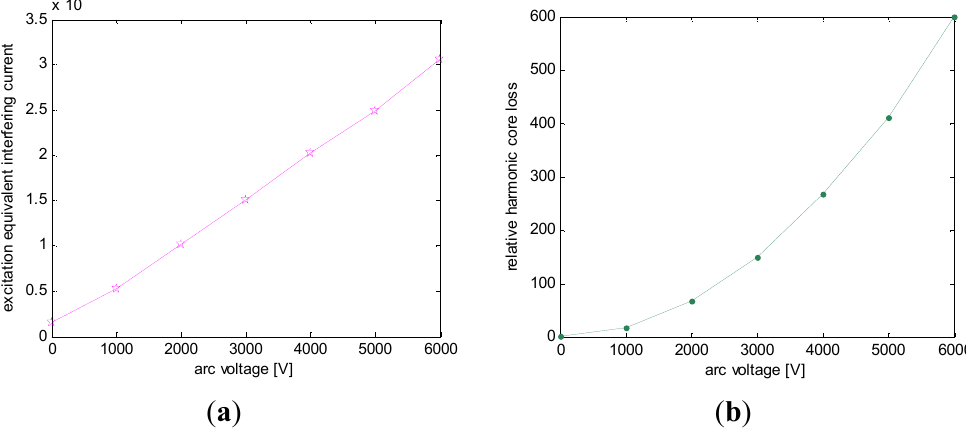
Figure 13. ( a ) Excitation equivalent interfering current and ( b ) Relative harmonic core